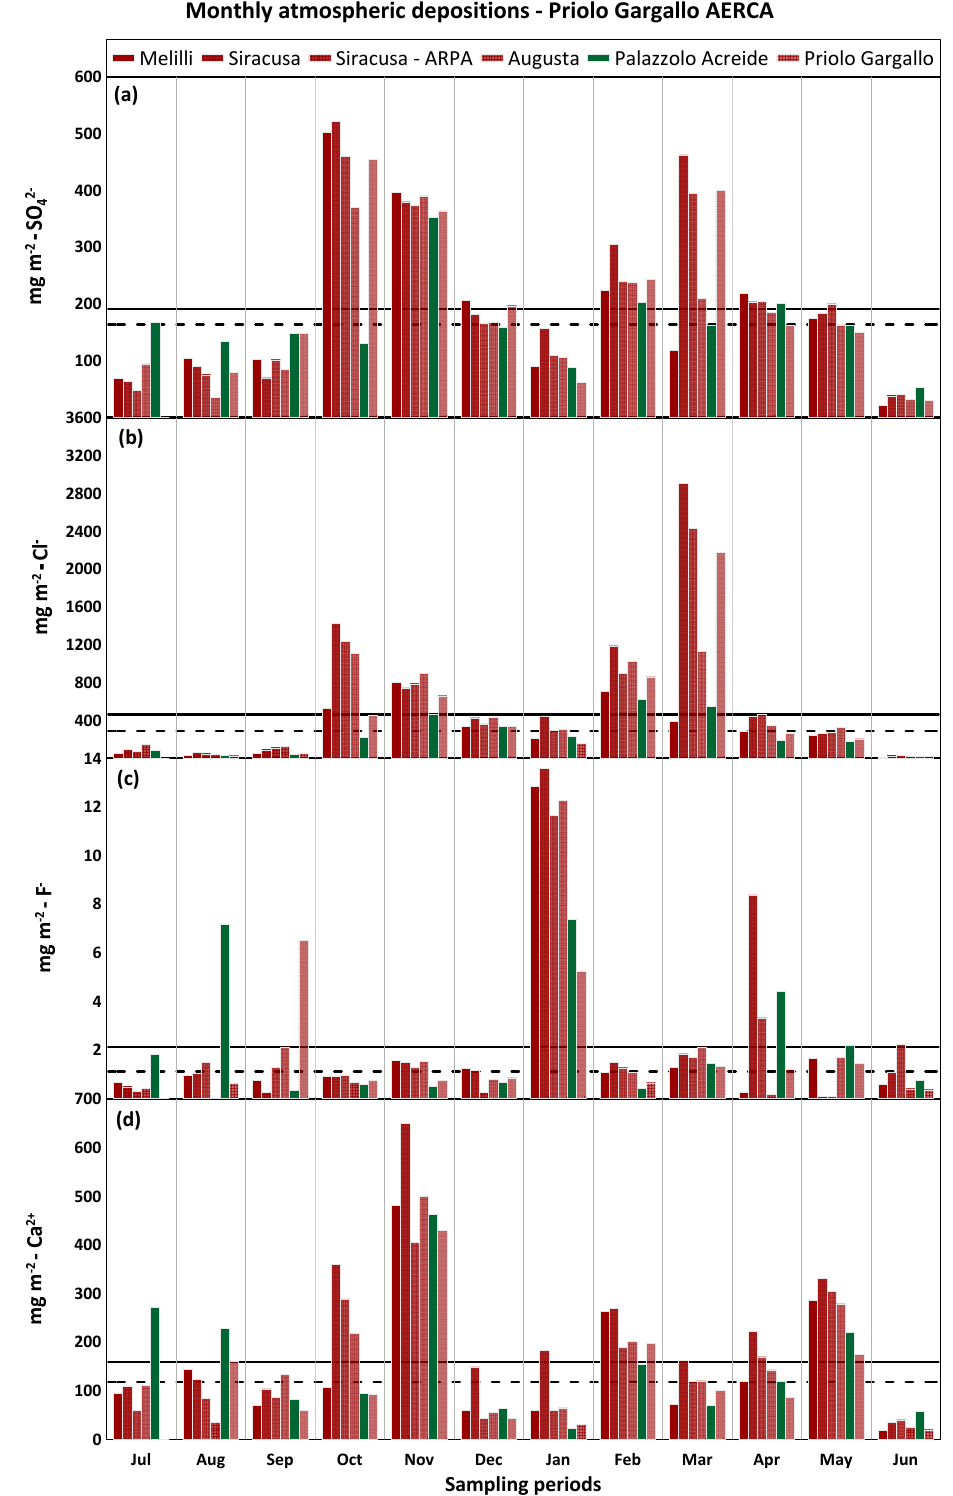
Figure 11. Monthly atmospheric depositions (mg m − 2 ) for sulphate ( a ), chloride ( b ), fluoride ( c ), and calcium ( d ) at Priolo Gargallo AERCA. The solid black lines are mean values; the dashed lines are median values.